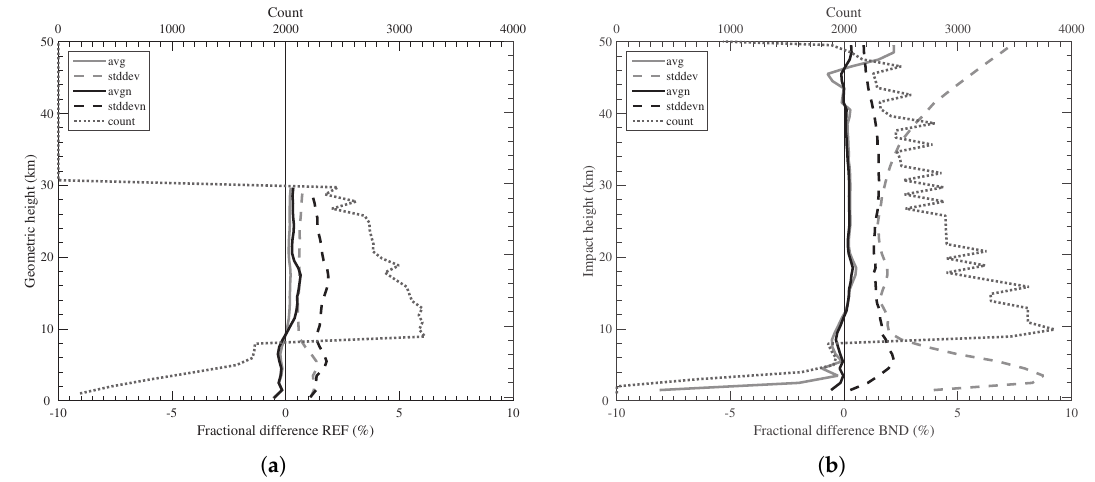
Figure 1. Statistics of the fractional differences ((O-B)/B) (avg and stddev) and normalized by the error observation (avgn and stddevn), between ( a ) the observations and modeled refractivity profiles as a function of the geometric height and ( b ) the observations of bending angles and those simulated from the model as a function of the impact height. Count refers to the total refractivity ( a ) and bending angle ( b ) observations assimilated in each